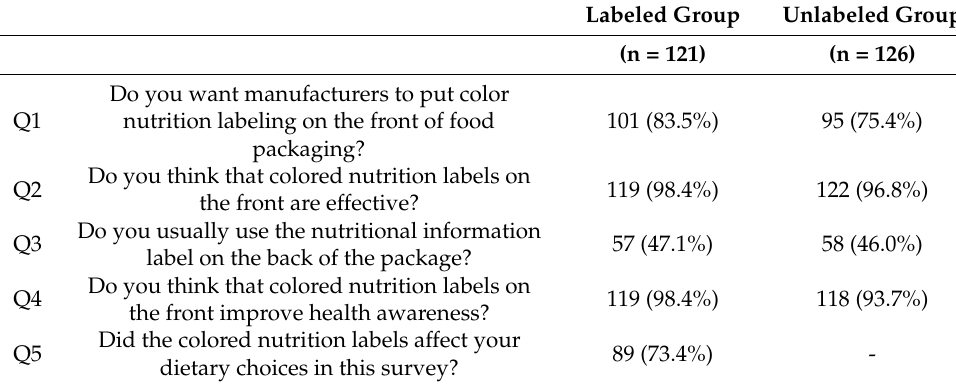
Table 4. Post-experiment questionnaire about TLF